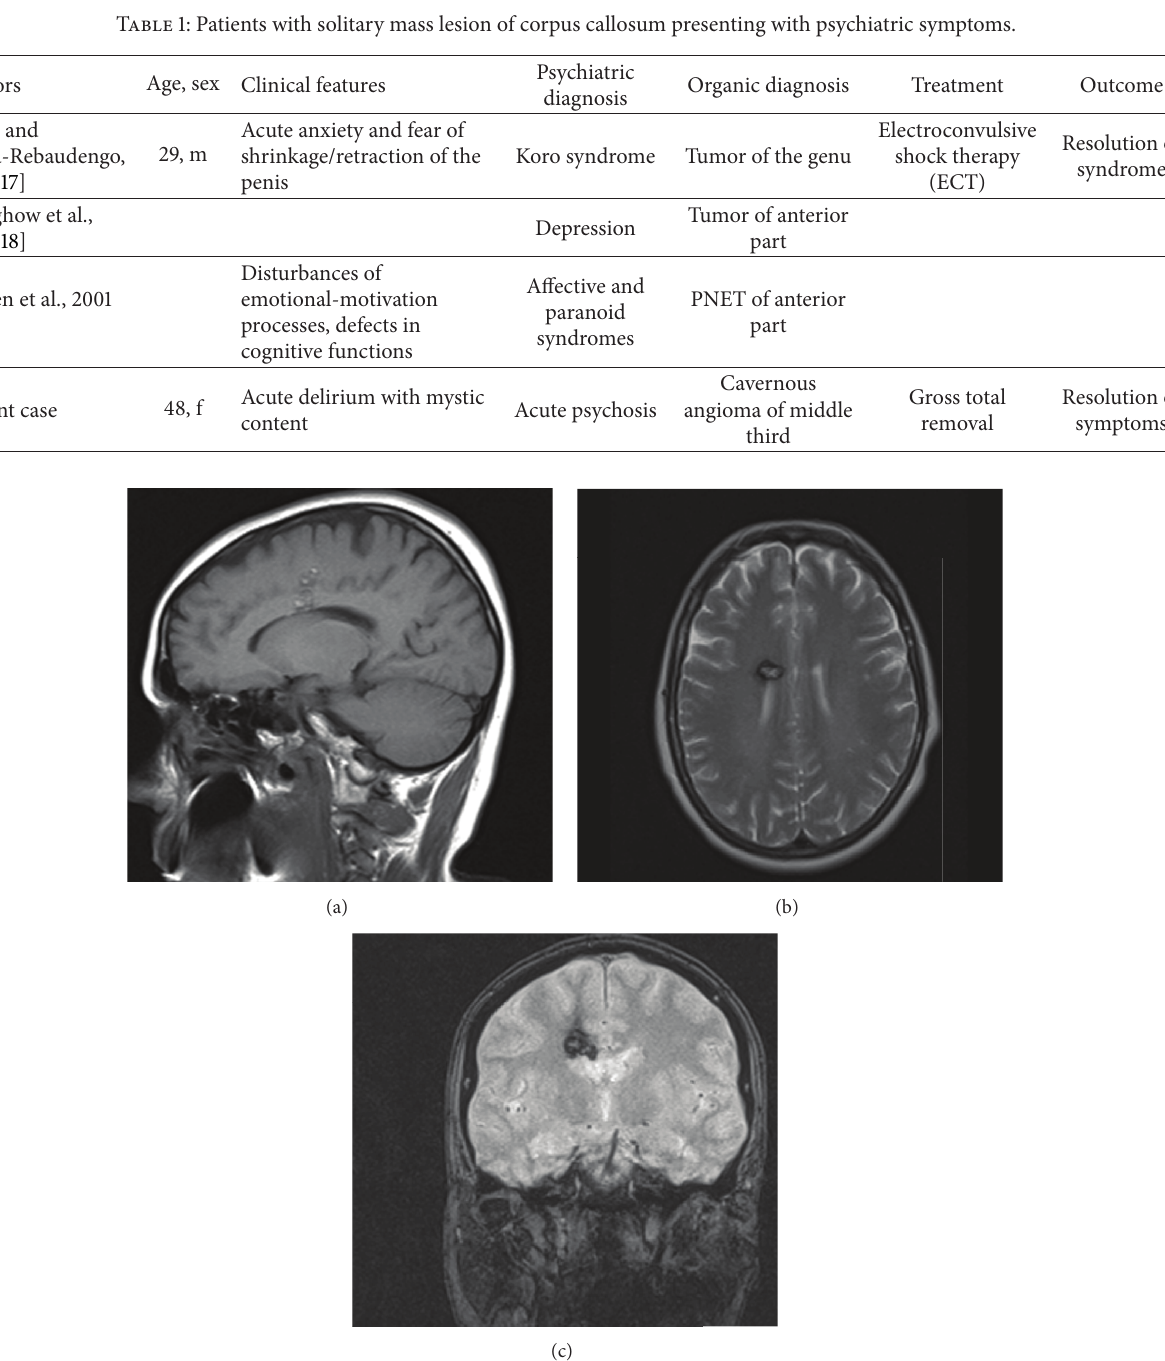
Figure 1: (a) Sagittal T1-weighted MR image showing the cavernous angioma embedded in the middle-third of the corpus callosum and extending into the cingular cortex. Axial T2-weighted (b) and coronal gradient echo (c) MR images evidence signs of a recent intralesional bleeding of the right-sided cavernous